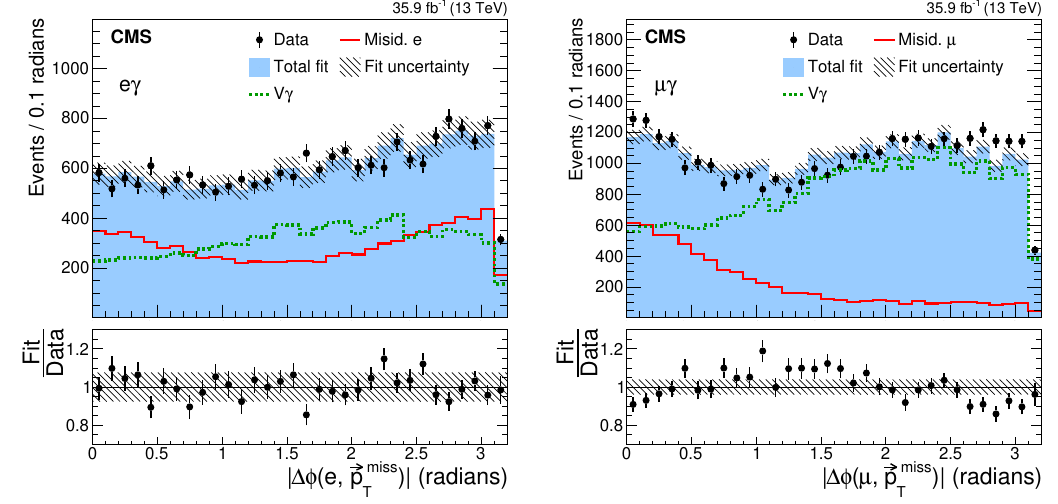
Figure 3 . The j (cid:1) (cid:30) ( ‘; ~p miss ) j distributions for the data in the 40 < p miss < 70 GeV control region T T (points) and the estimated V (cid:13) (dashed line) and misidenti(cid:12)ed-lepton (solid line) backgrounds for the e (cid:13) (left) and (cid:22)(cid:13) (right) channels. The (cid:12)lled histogram shows the result of the overall (cid:12)t and the hatched area indicates the (cid:12)t uncertainty. The vertical bars on the points represent the statistical uncertainty in the data. The lower panels show the ratio of the (cid:12)t result to the data.